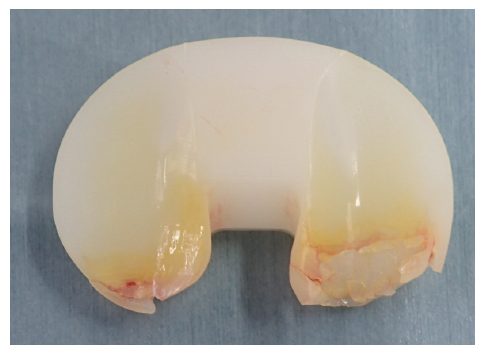
Figure 1. Retrieved conventional ultra-high-molecular-weight polyethylene after total knee arthro- plasty showing severe wear and delamination. Electron-beam (e-beam) sterilization has also been explored as a potential method for the sterilization of UHMWPE. For example, the degradation of electron-beam-sterilized conventional UHMWPE tibial plates was evaluated. While the resistance to the oxidative degradation of e-beam sterilization was comparable to that of gamma-air sterilization, it was still inferior to that of gamma-inert sterilization [14]. Alternatively, to improve the wear resistance of UHMWPE, carbon-fiber-reinforced polyethylene (Poly Two; Zimmer, Warsaw, IN, USA) and UHMWPE with increased crystallinity (Hylamer; DePuy-DuPont Orthopedics joint venture, Newark, DE, USA) were introduced; however, their use was ultimately discontinued because of unacceptable rates of wear